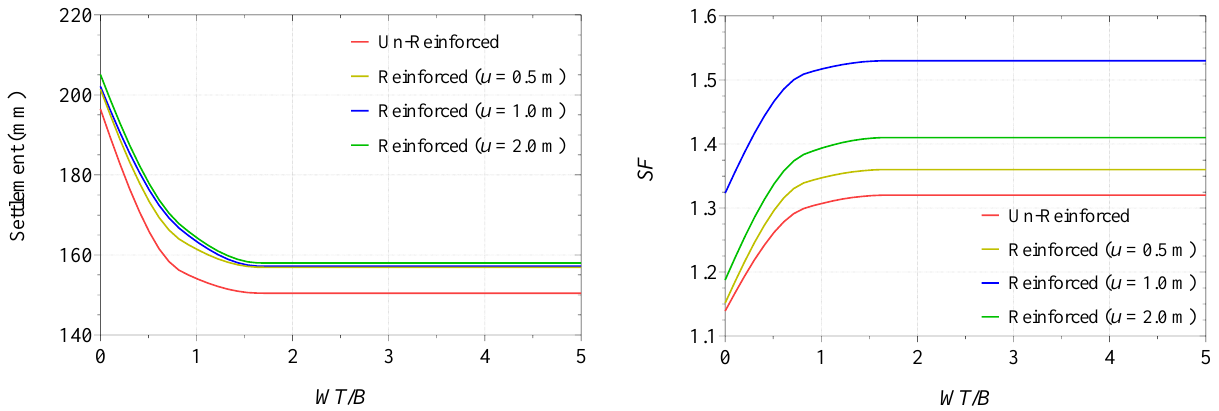
Figure 4. The settlement and the safety factors of the soil-footing system due to the changes of WT/B and u (for all tests: h=0.5 m, b=12 m, n=3, and St=50 kN/m)